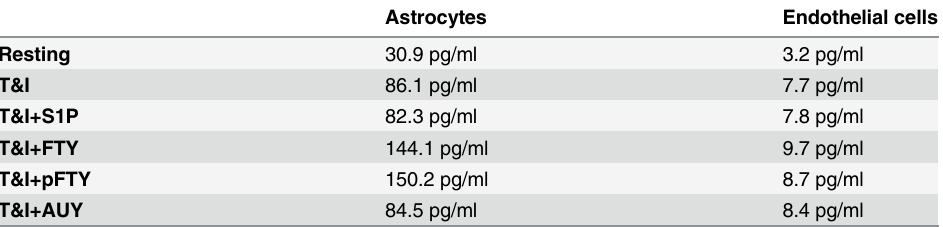
Table 2. Evaluation of GM-CSF release by ELISA. Values report the quantification of GM-CSF released by hAST and hBMVEC, respectively, after T&I exposure either alone or in the presence of S1P (50 nM), FTY (50 nM), pFTY (50 nM), and AUY (50